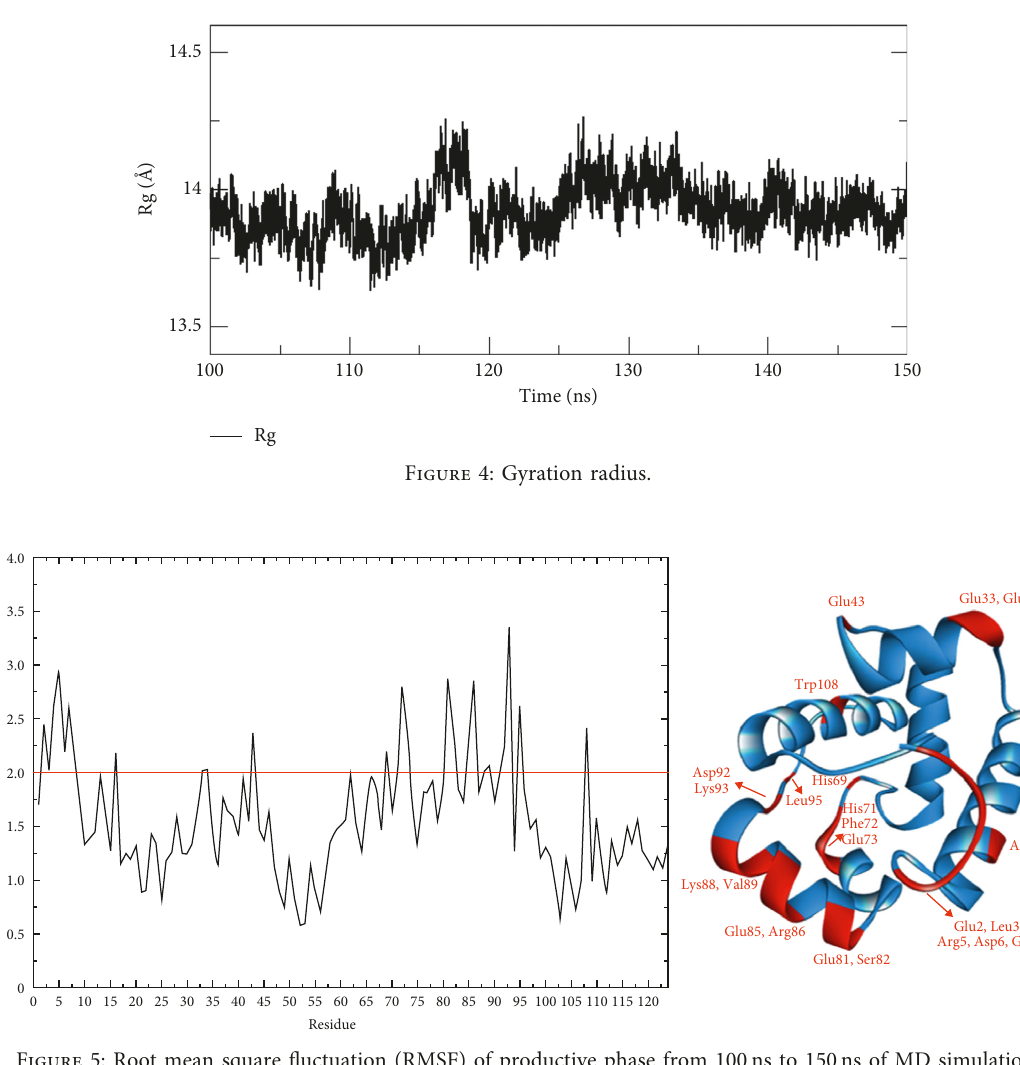
Figure 5: Root mean square fluctuation (RMSF) of productive phase from 100 ns to 150ns of MD simulation.